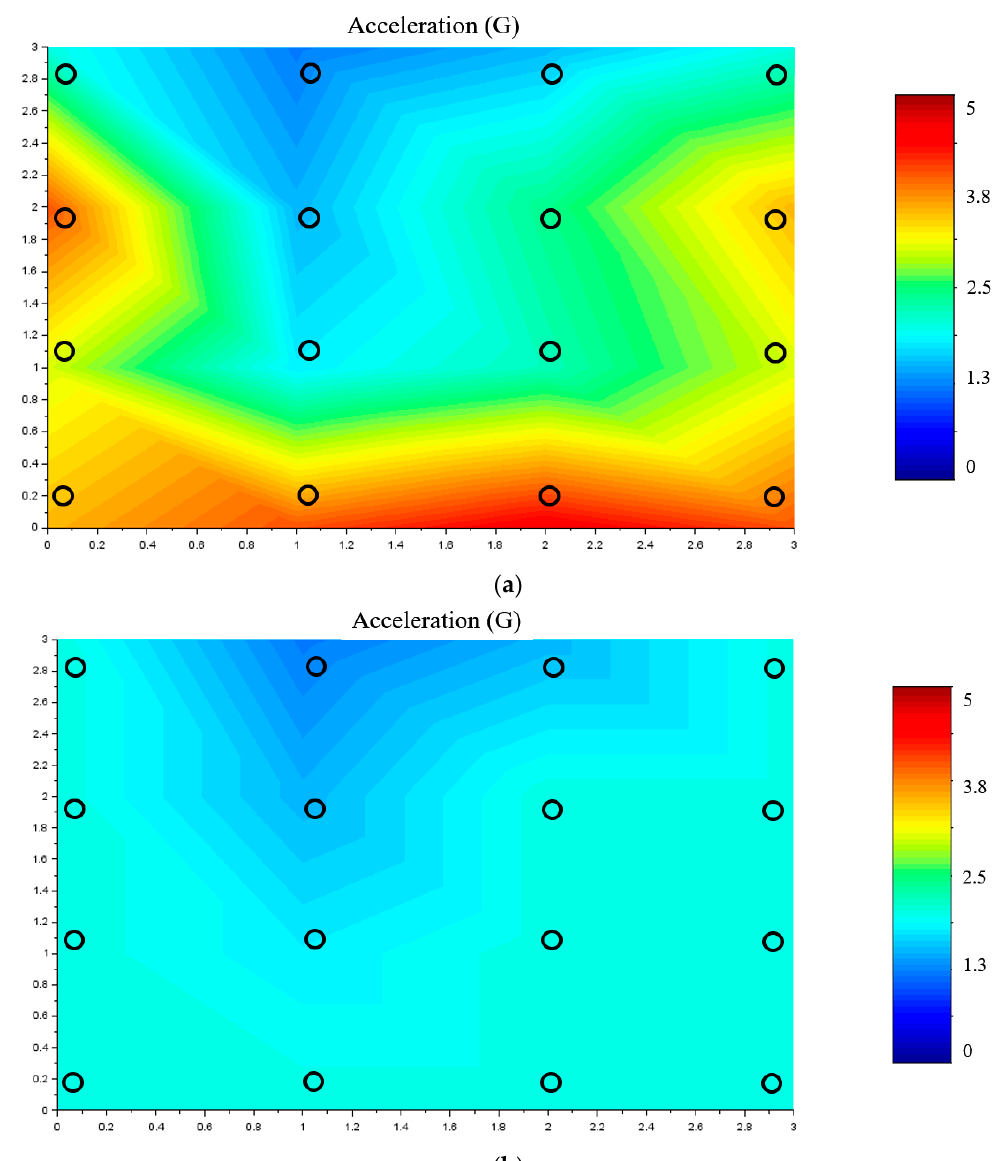
Figure 7. Accelerations distributed on a 10.1 inch commercial touchscreen (Samsung Galaxy Tab); non-uniform tactile feedback distribution ( a ) and the globally equalized distribution by our proposed algorithm ( b ). Note that the redder area means the stronger tactile feedback, and black circles are points where accelerations were measured.